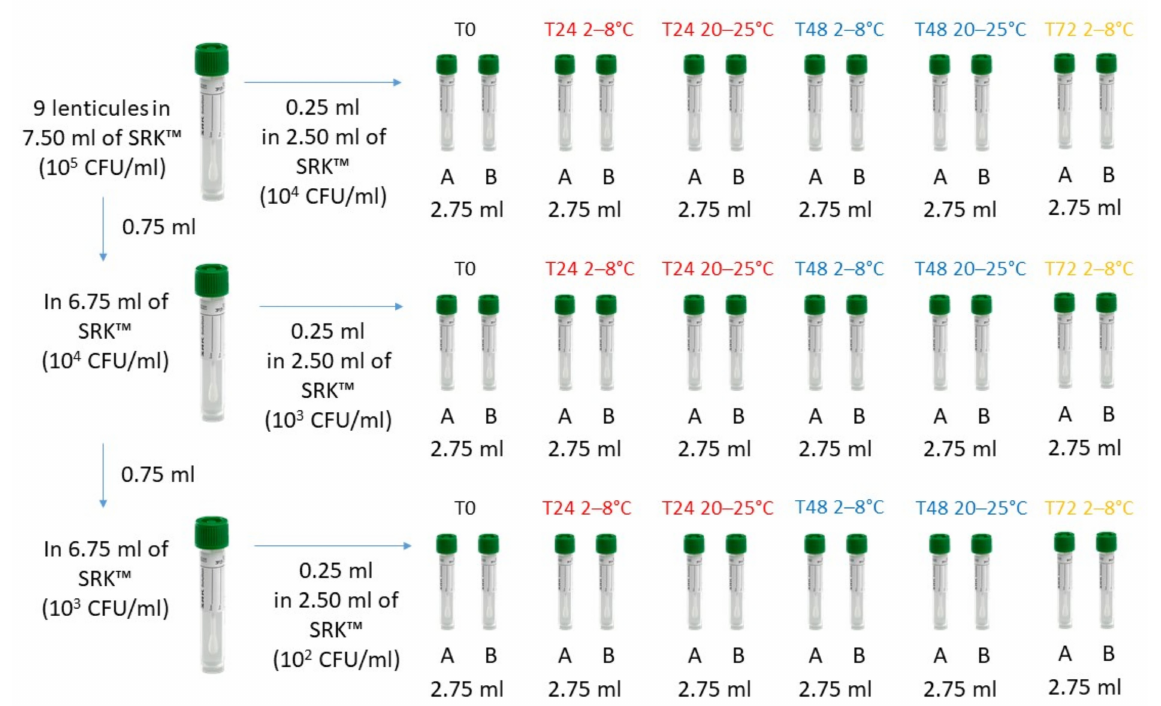
Figure 1. Scheme for the preparation of bacterial suspensions in SRK™ medium with final Lp concentrations of approxi- mately 10 4 , 10 3 and 10 2 CFU/mL. Bacteria recovery using culture (tube A) and molecular methods (tube B) was evaluated at time 0, 24 and 48 h (T0, T24, T48) following storage at 20–25 ◦ C and at time 0, 24, 48 and 72 (T0, T24, T48, T72) hours at 2–8 ◦ C,